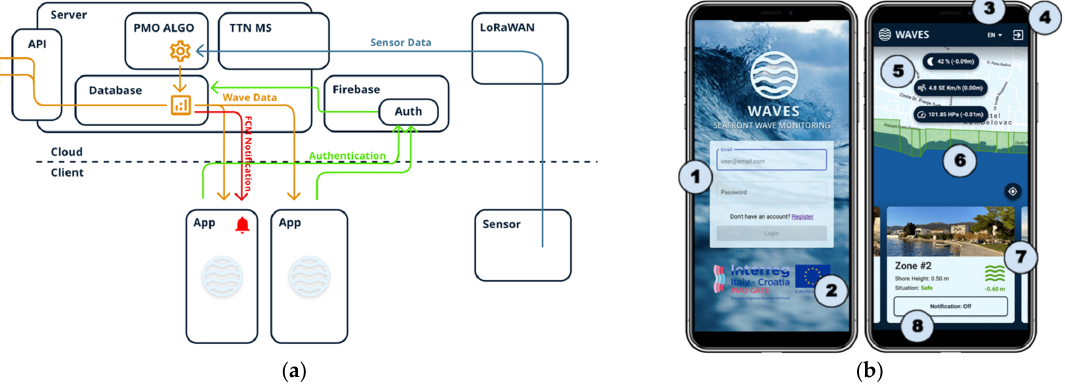
Figure 8. ( a ) High-level overview of the implementation of the solution, ( b ) Front-end interface of the mobile application.